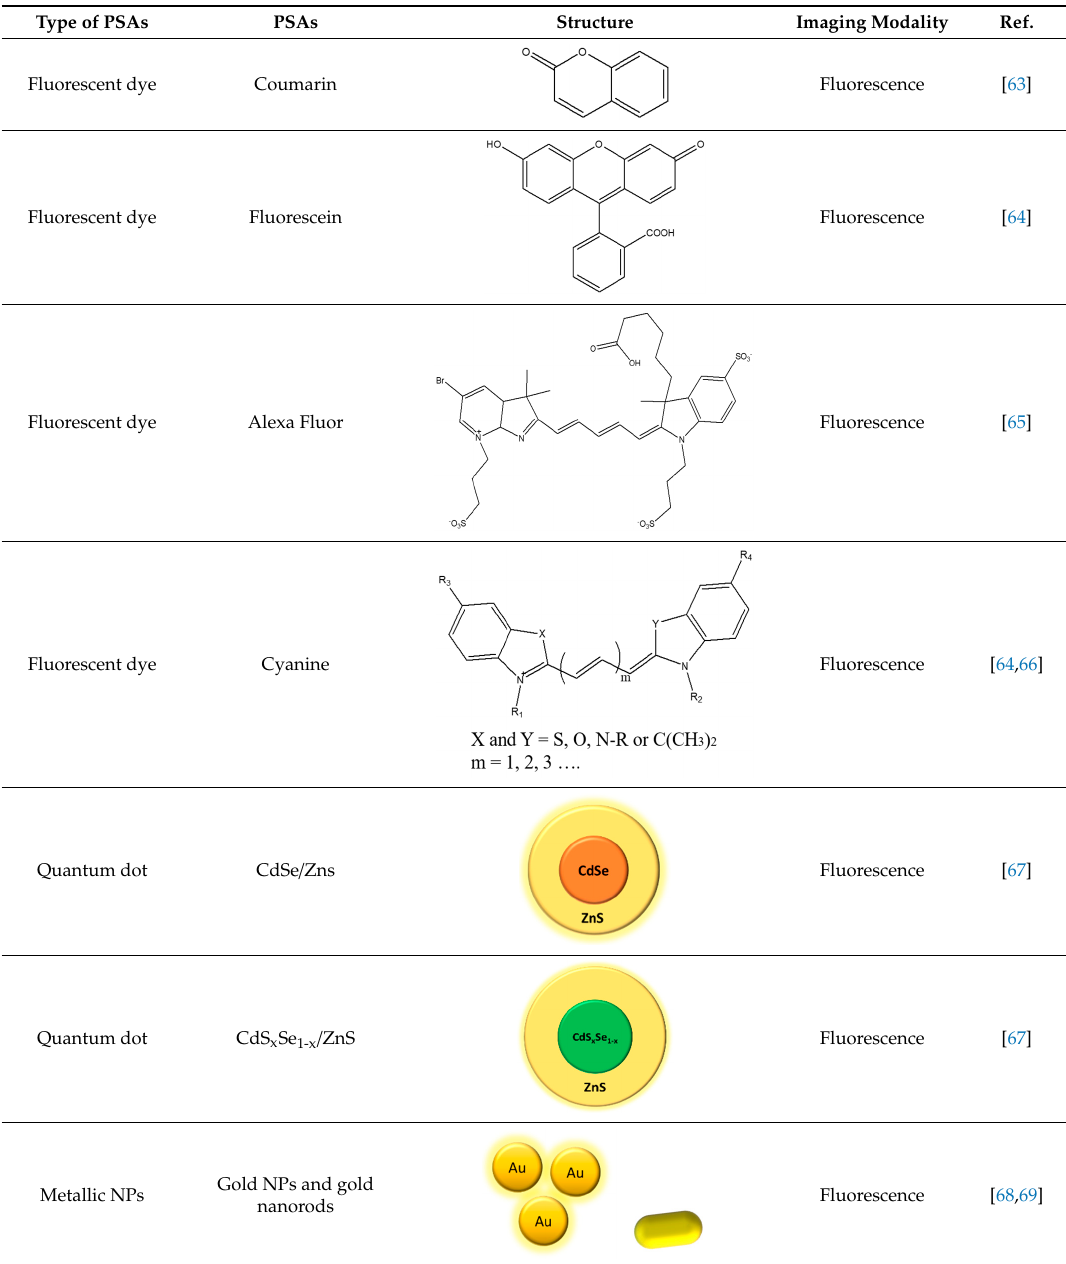
Table 2. Imaging PSAs used in OI.